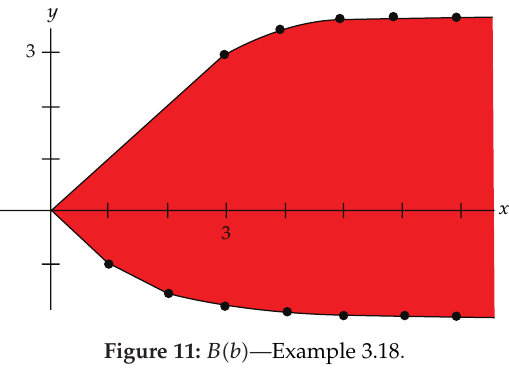
Figure 11: B (cid:2) b (cid:3) —Example